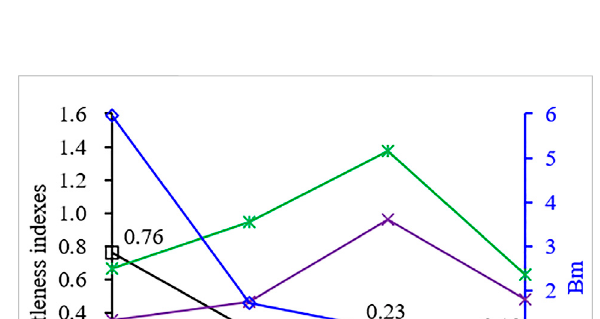
FIGURE 7 Calculation results of brittleness index for granite under different con fi ning pressures.